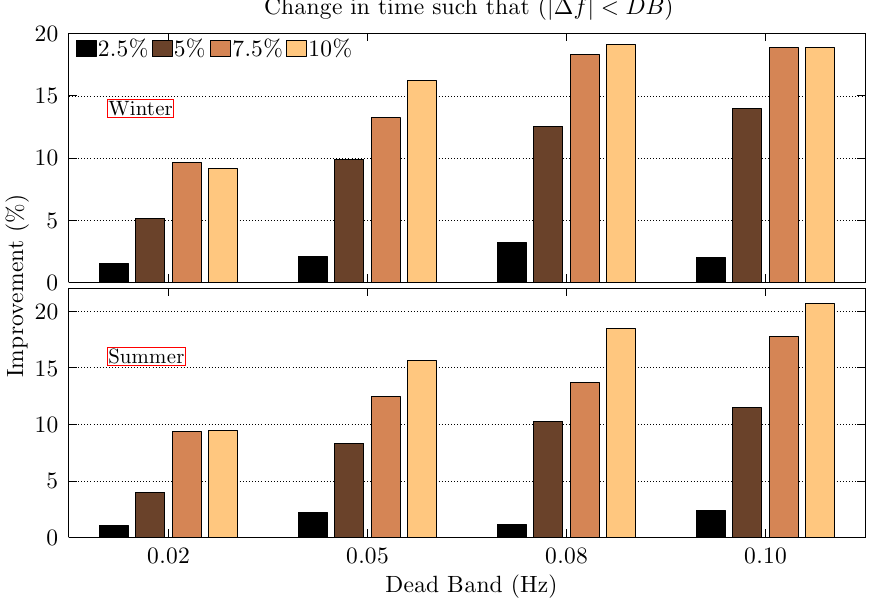
∆ f < dead band (DB) for different governor dead | |